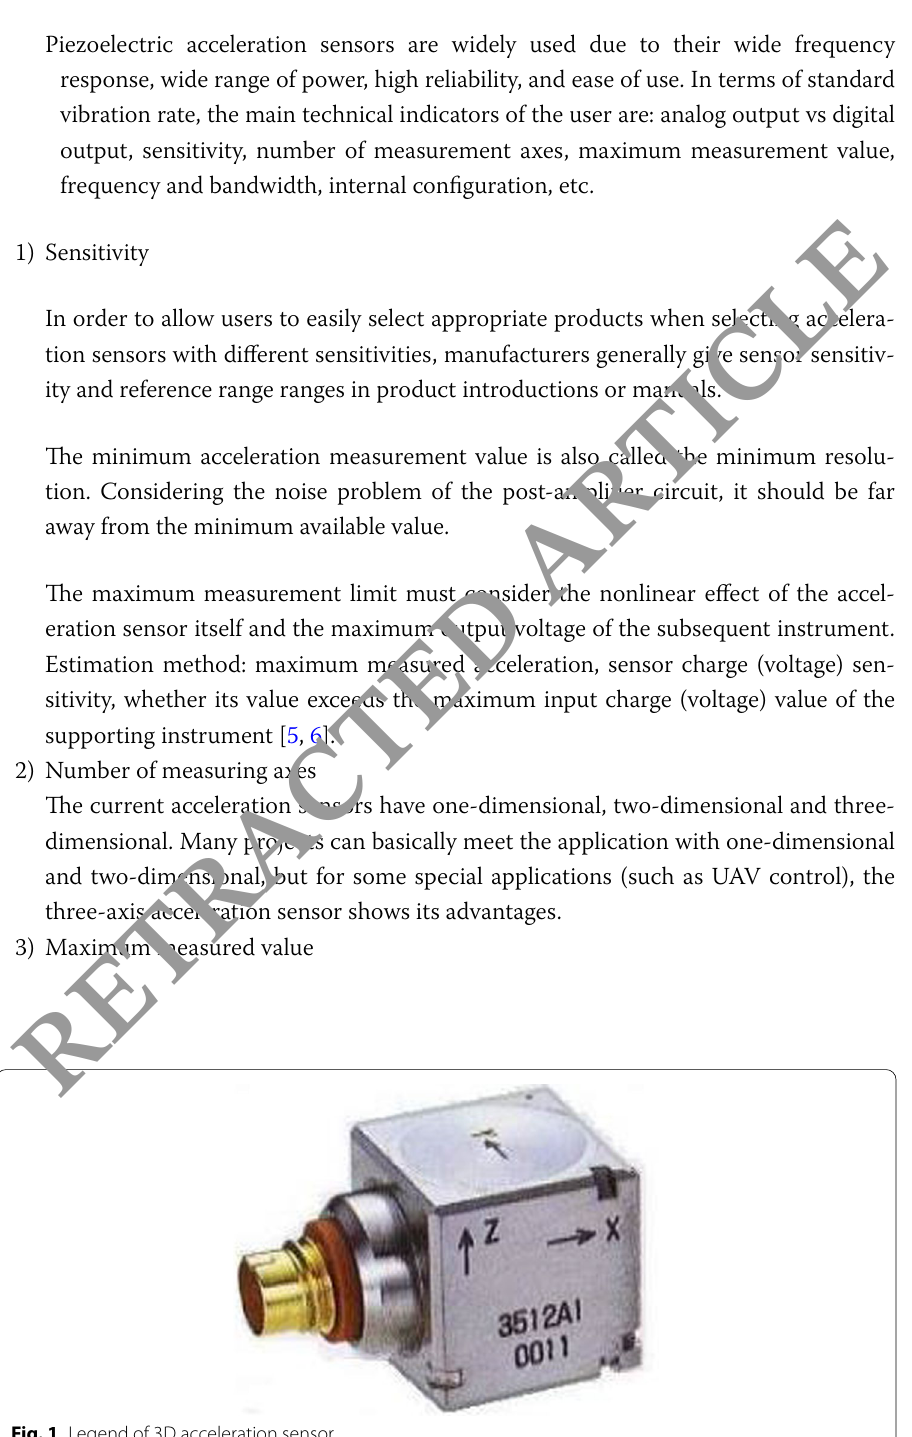
Fig. 1 Legend of 3D acceleration